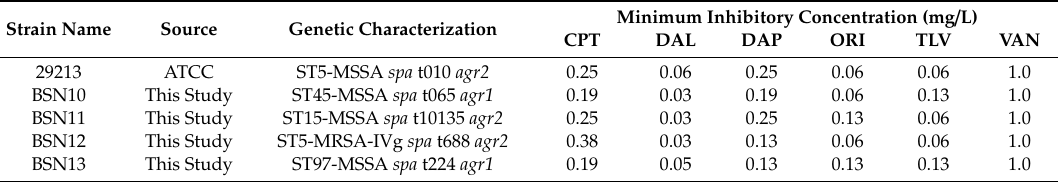
Table 3. Study strains. Minimum inhibitory concentrations were determined by Etest (Biom é rieux) or broth microdilution consistent with CLSI standards [18]. BSN strains are patient isolates obtained from consecutive patients presenting to the Detroit Medical Center with staphylococcal bacteremia. ATCC, the American Type Culture Collection, Manassas,